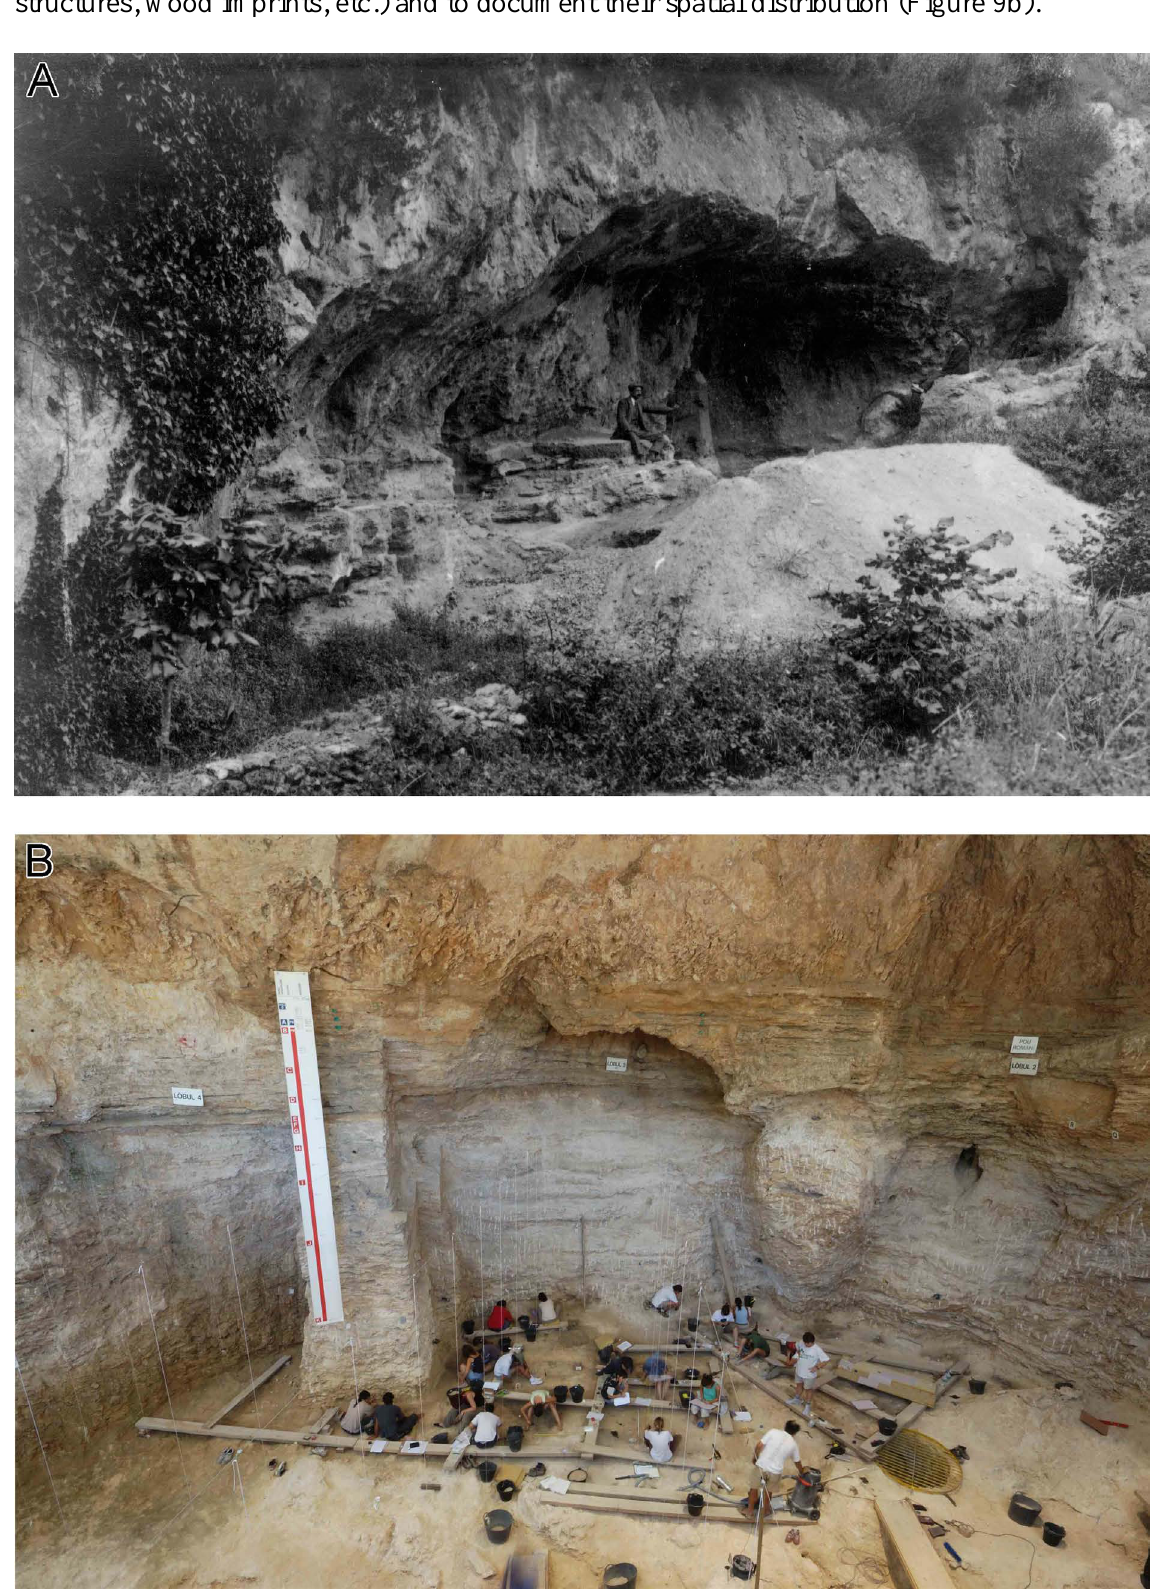
Figure 9. A) Amador Romaní at the site during the first research phase (Bartrolí et al. 1995). B) Image of the actual fieldworks at the Abric Romaní during the excavation of level M